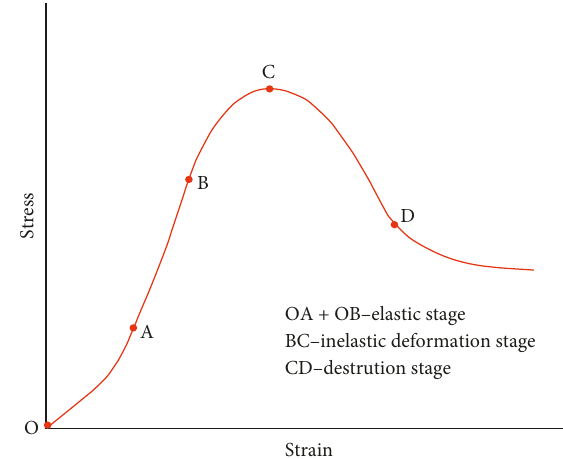
Figure 4: Stress-strain curve of CPB under TC coupling